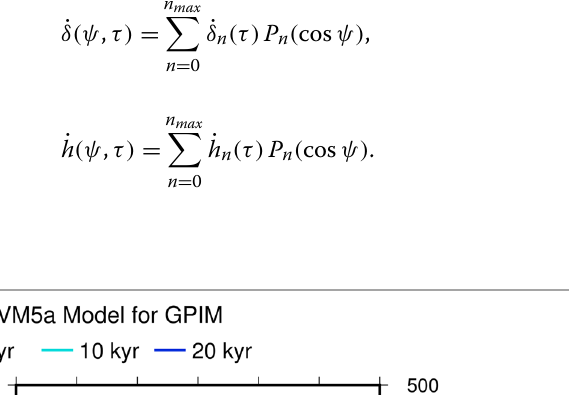
˙ h −˙ δ n (τ) with degree ( n ) and time ( τ ). d The n (τ) to ˙ h (ψ , τ) with angular distance ( ψ ) and time ( τ ). f The variation in the